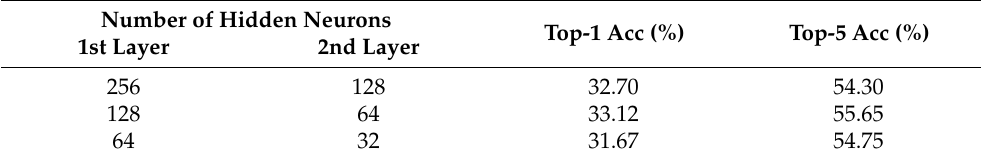
Table 7. Different numbers of hidden neurons in each bidirectional layer. The evaluation is taken in the Kinetics